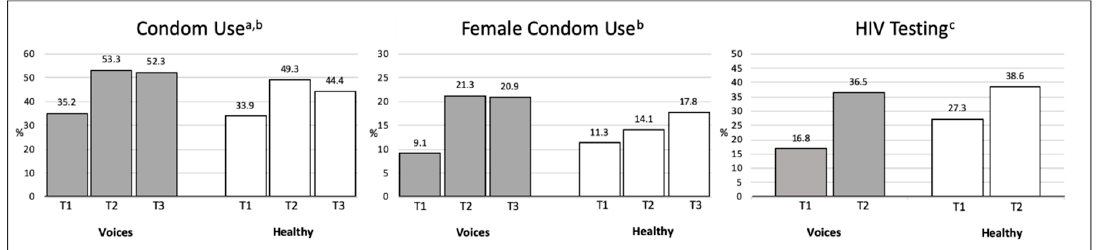
Figure 1. Changes over time in Latinas’ condom use, female condom use, and HIV Testing, South Florida, 2015–2017. a Condom use was assessed with four items regarding the frequency of vaginal and anal sex with primary sex partner and vaginal or anal sex with a casual sexual partner in the past 30 days. b Comparison of baseline, 6-months, and 12-months follow-ups. c HIV testing during the past 6 months. Comparison of baseline and combined answers from 6-months and 12-months follow-ups.